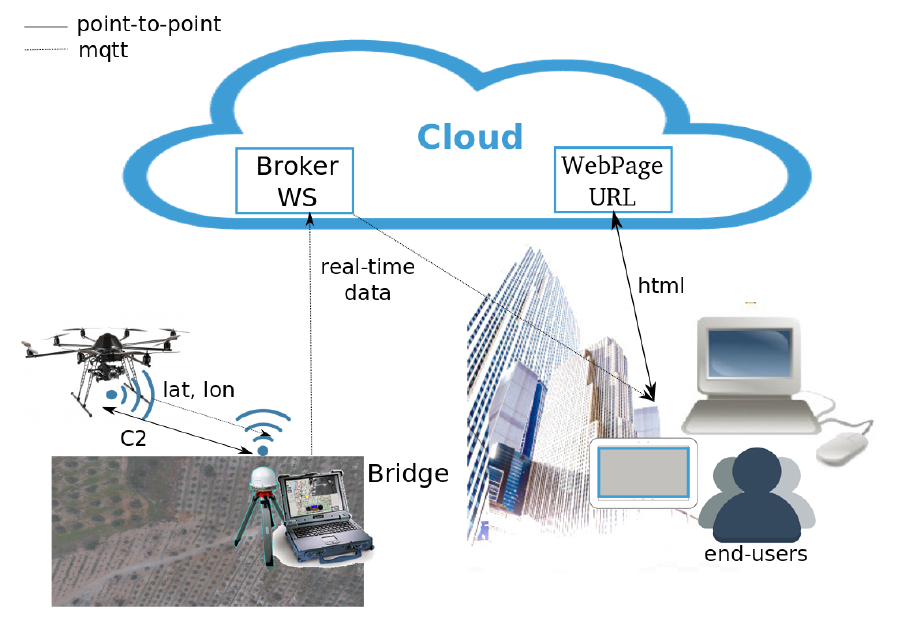
Figure 8. The architecture of the drone-in-the-cloud solution is able to deliver the relevant information to the end-users on their own devices during the UAV